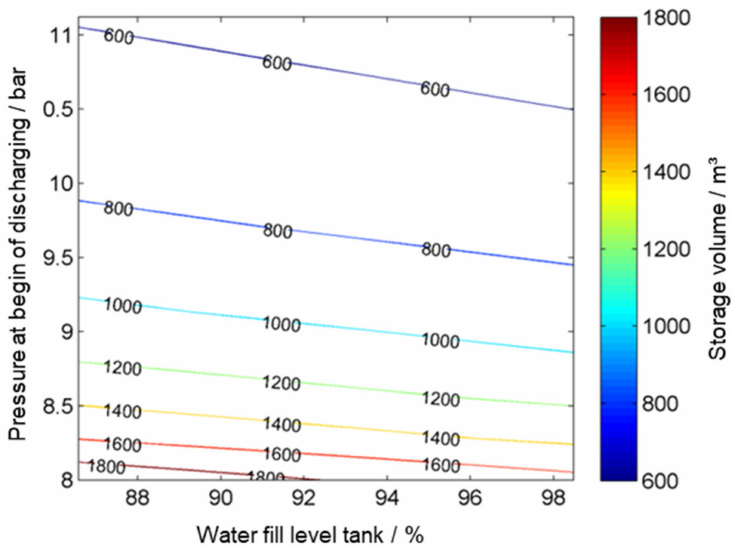
Figure 16. Relationship between water level and storage